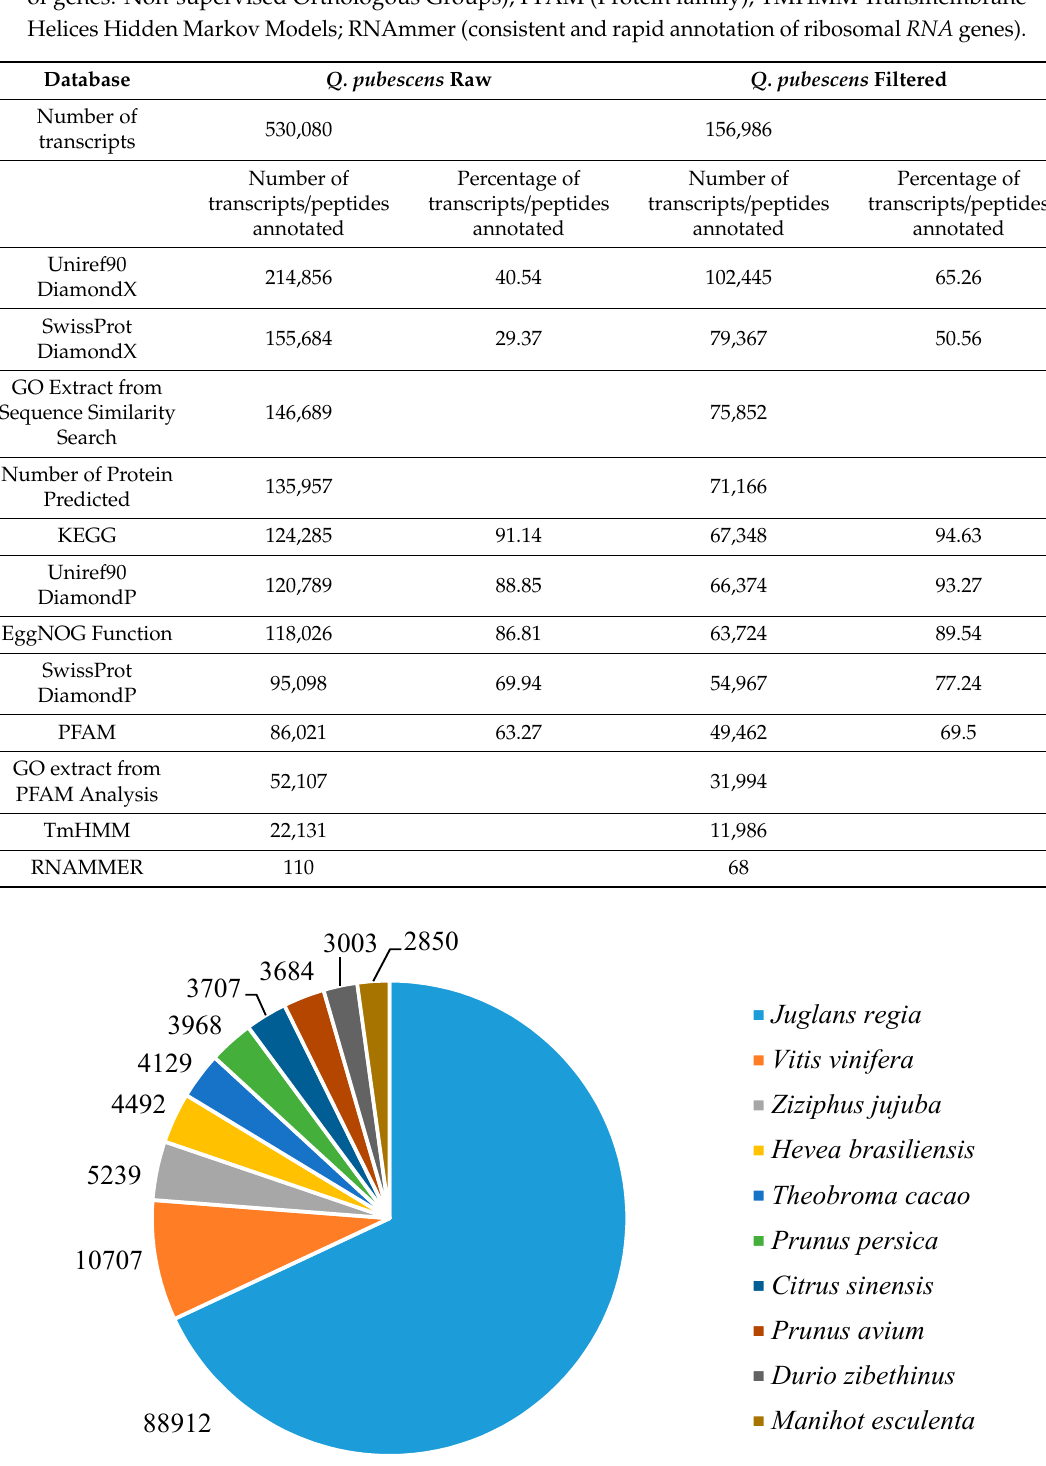
Figure 3. Plant species distribution of DiamondX searches on NCBI nr database of Q. pubescens transcripts. Percentage of total top ten homologies. Filtering at E value threshold < 10 × 10 − 10 . Table 3. Summary of annotations of raw and filtered Q. pubescens genome-guided sequence assembly. KEGG (Kyoto Encyclopedia of Genes and Genomes); eggNOG database (evolutionary genealogy of genes: Non-supervised Orthologous Groups); PFAM (Protein family); TMHMM Transmembrane Helices Hidden Markov Models; RNAmmer (consistent and rapid annotation of ribosomal RNA genes). Database